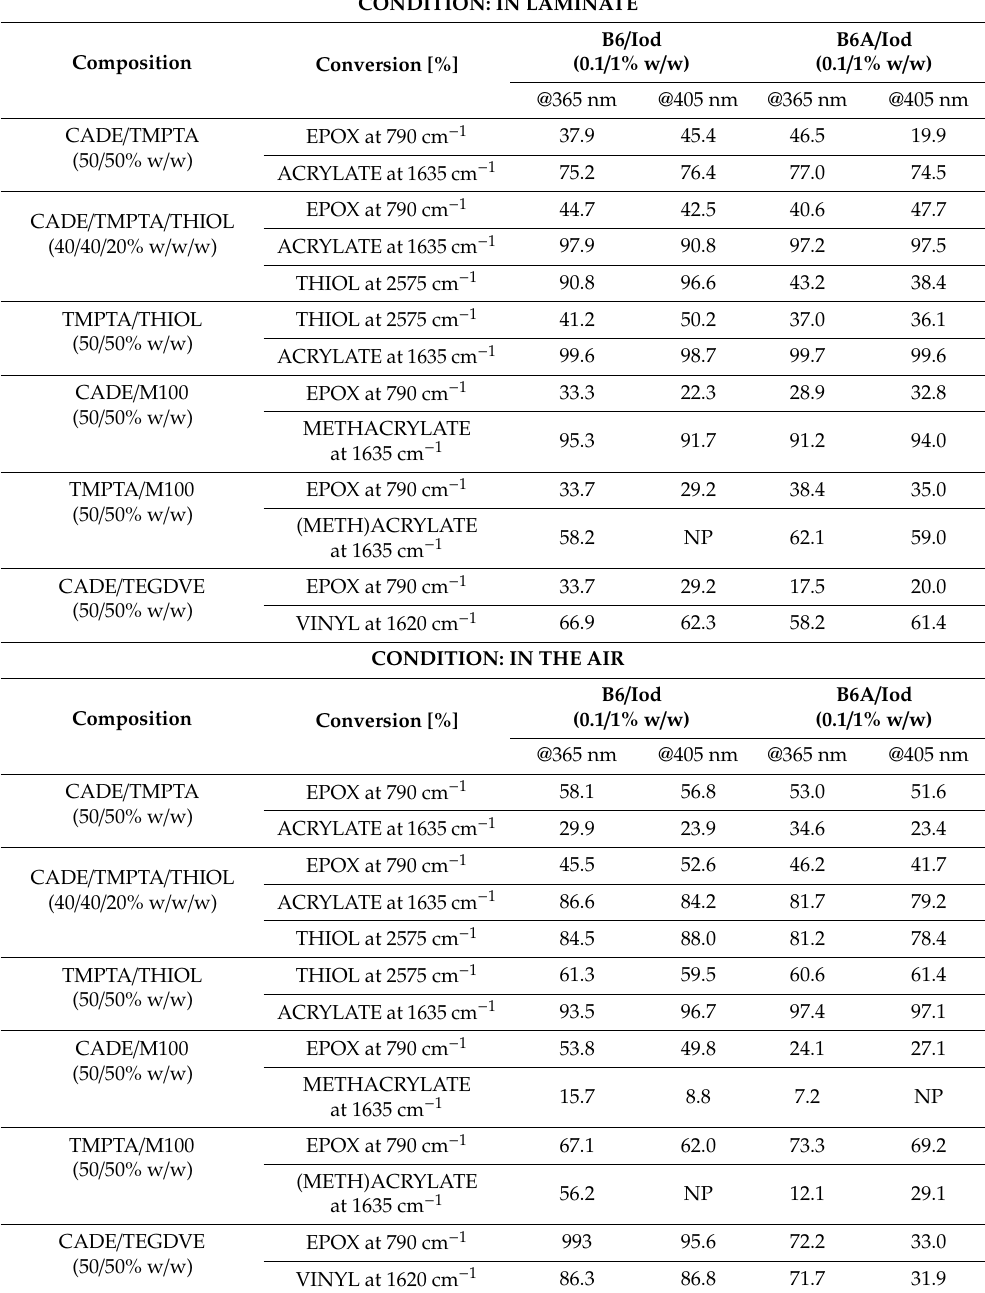
Table 5. Summary of functional group conversions of used monomers, using photoinitiating system based on bis-(4- t -butylphenyl)iodonium hexafluorophosphate (Speedcure 938 wt 1%)